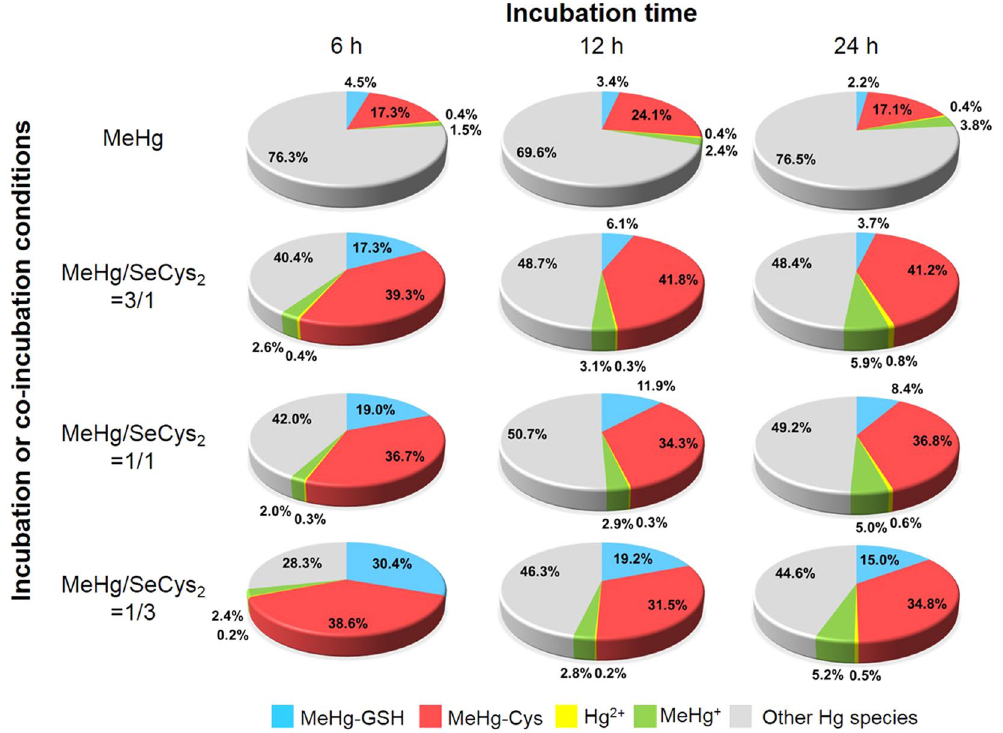
Figure 5. Proportions of MeHg-GSH, MeHg-Cys, Hg 2 + , MeHg + and other species of mercury in a HepG2 cell. The total amounts of mercury were obtained by ETV-ICP-MS determination; the mount of Hg 2 + and MeHg + were obtained by chip-based on-line MSPME-microHPLC-ICP-MS analysis; the amount of MeHg-GSH and MeHg-Cys were obtained by C18 RP-HPLC-ICP-MS measurement; the normalization method was use for the calculation. (The values of 4.5%, 3.4%, 2.2%, 6.1%, 3.7% and 8.4% of MeHg-GSH were calculated based on the semi-quantified results because the concentrations of MeHg-GSH under these incubation conditions are lower than the LOQ but higher than the LOD by RP-HPLC-ICP-MS